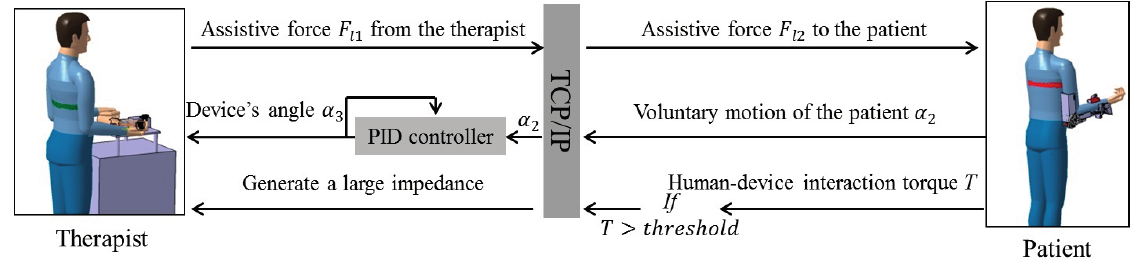
Figure 3. Schematic of active